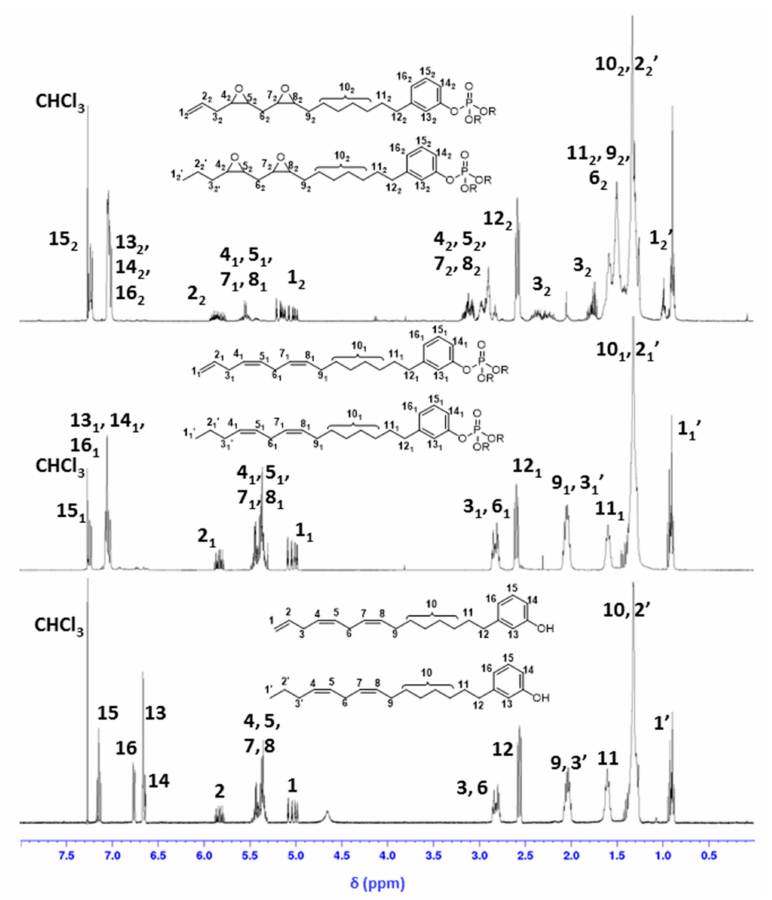
Figure 3. Stacked 1 H NMR spectra of: Cardanol (bottom), TCP (middle) and TECP (top) in CDCl 3